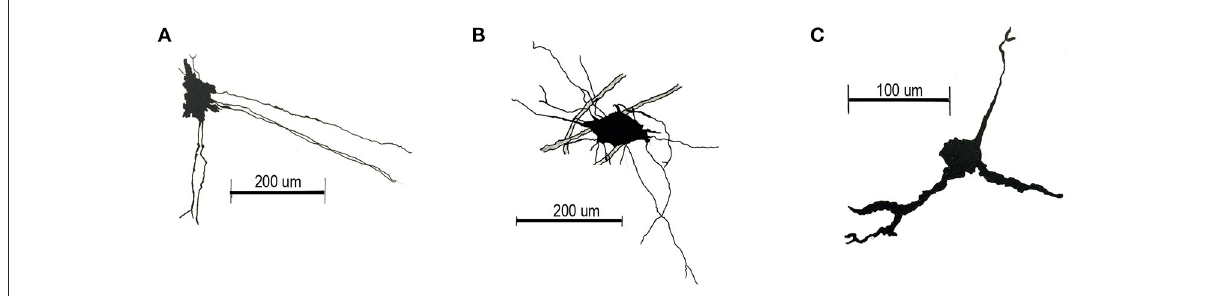
FIGURE1 Camera lucida drawings of main cell types of the SVCC. (A) Cells located in the lateral region of the SVCC have an elongated soma (diameter 32.506 ± 0.808 µ m), long processes that project toward the middle region and processes that extend ventrally. (B) Star-shaped soma cells (diameter 36.957 ± 0.774 µ m) with a long lateral process and one that projects ventrally. (C) Small cells (diameter 17.728 ± 2.223 µ m), with two processes projecting ventrally and a short lateral